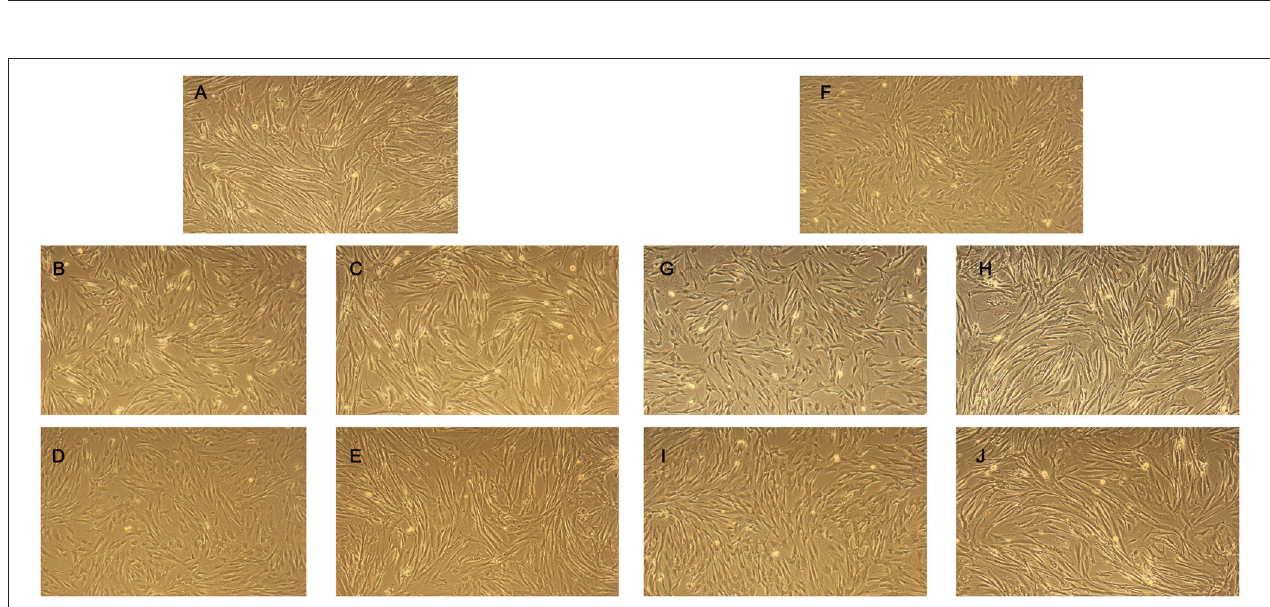
FIGURE 5 | Effect of perfusion fluid on morphology of attached MSC. (A) pMSC in regular culture medium. (B,C) pMSC in culture medium or perfusion fluid, respectively for 30min. (D,E) pMSC cultured in culture medium or perfusion fluid, respectively for 120min. (F) hMSC in regular culture medium. (G,H) hMSC cultured in culture medium or perfusion fluid, respectively for 30min. (I,J) hMSC cultured in culture medium or perfusion fluid, respectively for 120min.